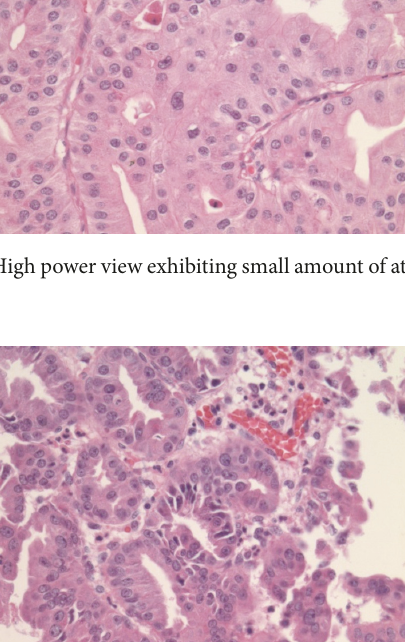
Figure 1: PGA located in the second portion of the duodenum opposite to the ampulla.